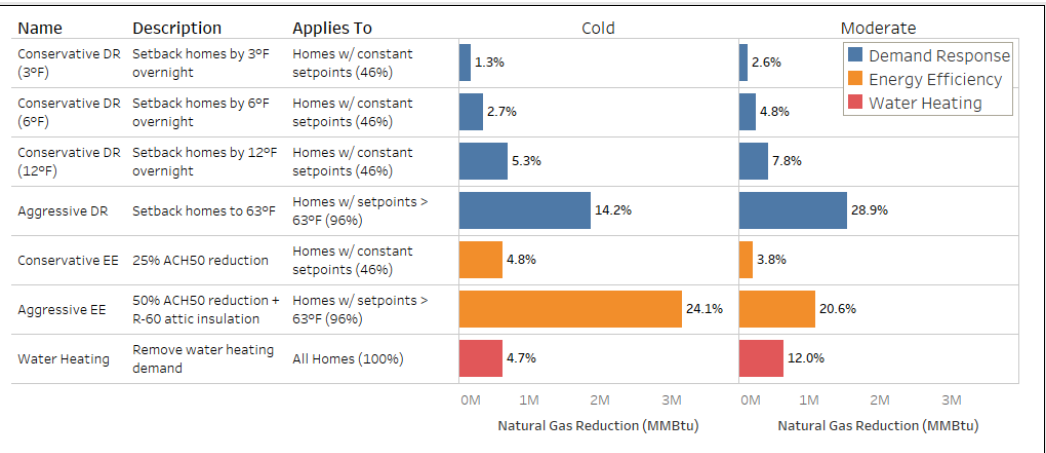
Figure 6. Total natural gas reduction from the baselines across 48 h periods of cold and moderate outdoor temperatures. The percentage of homes in which each case applies is shown in parenthesis in the “Applies To” column. The percentages shown at the end of each bar are the reductions in total natural gas demand from the baseline. The cold period refers to 5 January 2018–7 January 2018, coinciding with the bomb cyclone, and the moderate period refers to 22 January 2018–24 January 2018. ACH50 is the air changes per hour at 50 pascals pressure differential, a measure of the level of air sealing in a home.